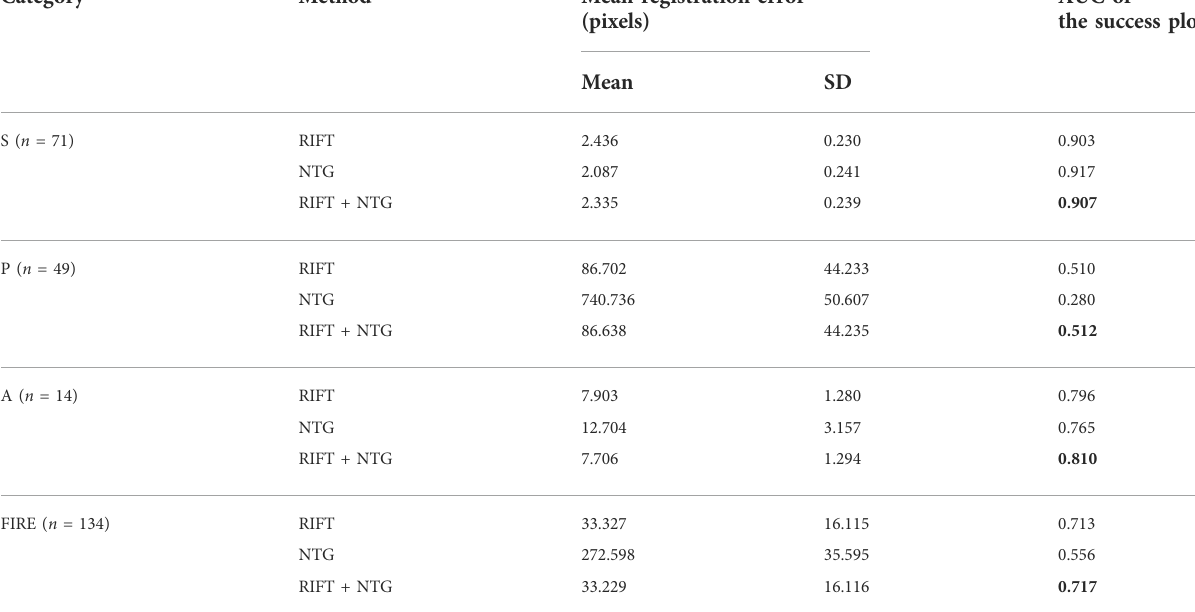
Bold values represent the highest AUC in the speci fi c category.